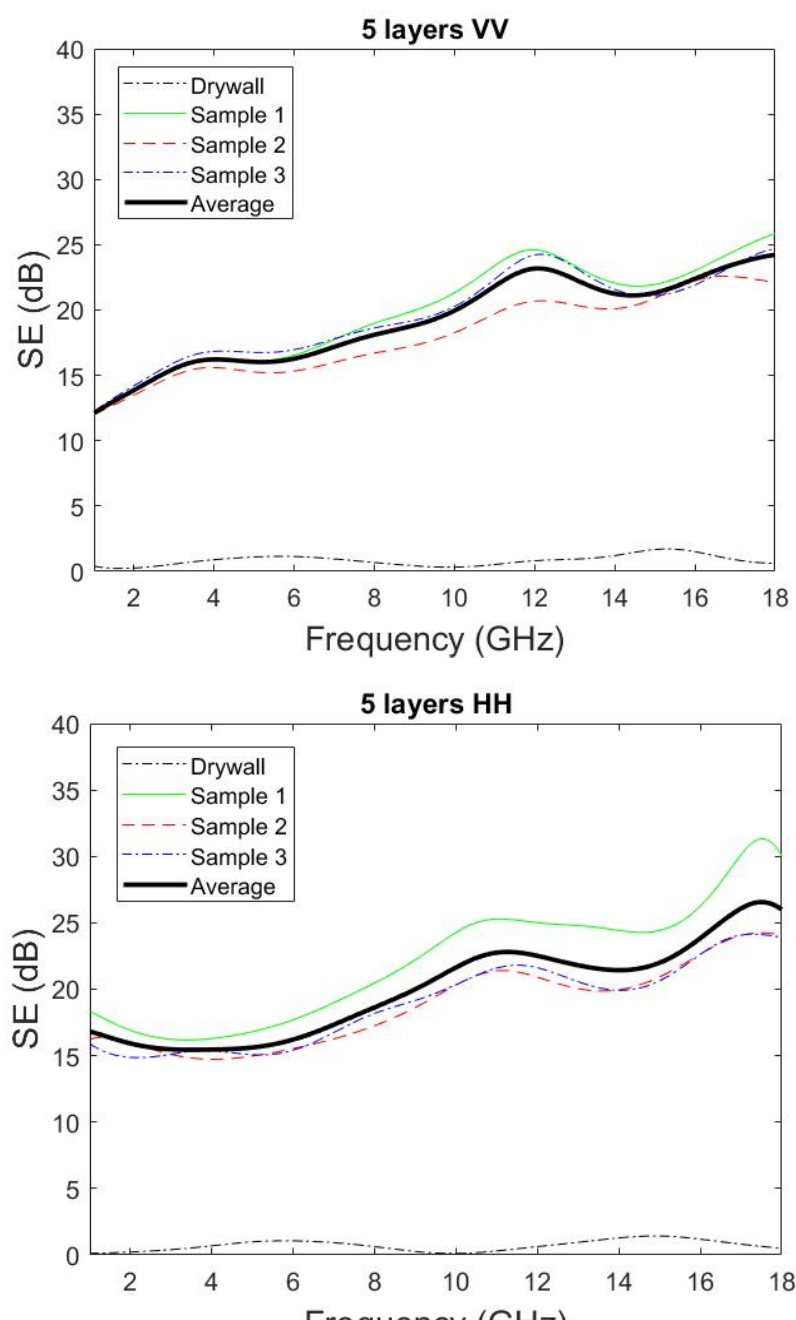
Figure 7. Plots of the SE versus frequency for 5 ‐ layer samples. Vertical polarization ( top panel ); horizontal polarization ( bottom panel ).